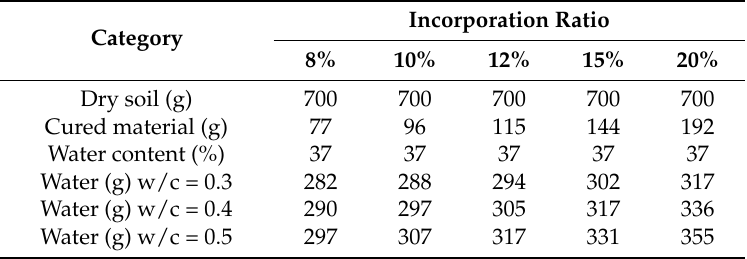
Table 6. Content of each admixture of the curing agent.